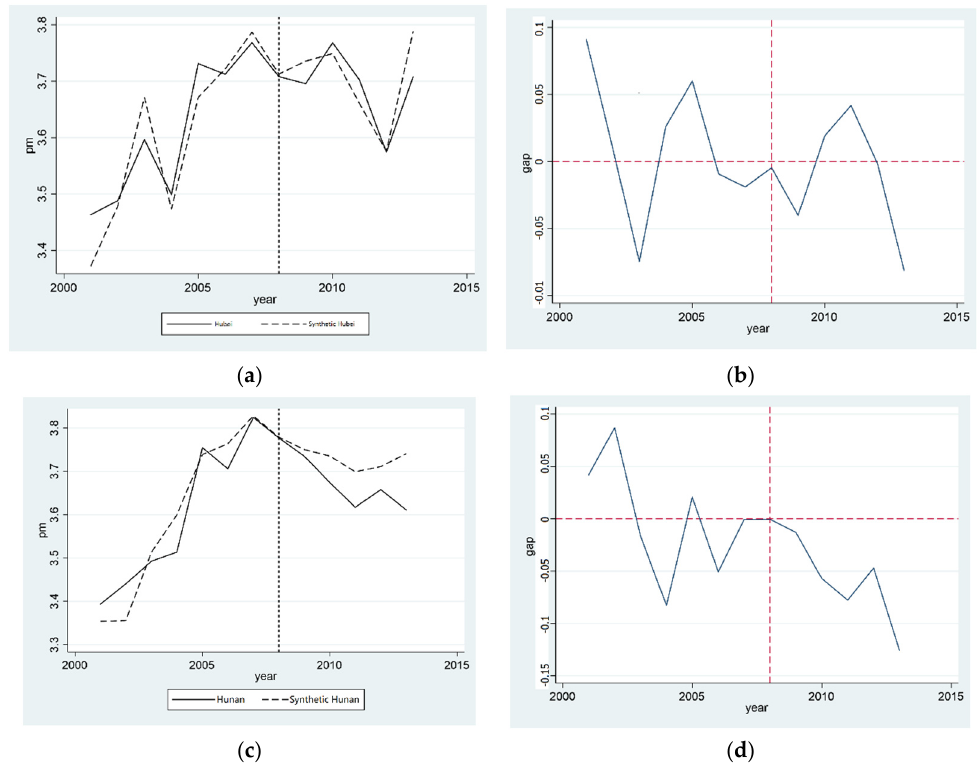
Figure 1. Comparison of PM2.5 particulate concentration reduction effect in provinces established in the “two-oriented society” pilot. ( a ) Comparison of PM2.5 reduction in Hubei; ( b ) Gap in PM2.5 reduction in Hubei; ( c ) Comparison of PM2.5 reduction in Hunan; ( d ) Gap in PM2.5 reduction in Hunan.